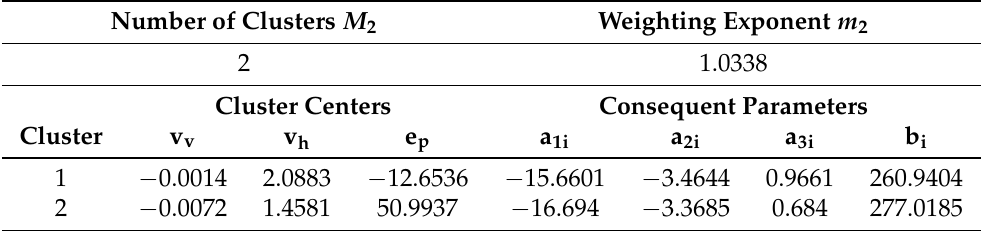
Table 6. Parameters of the second power-estimation subsystem.